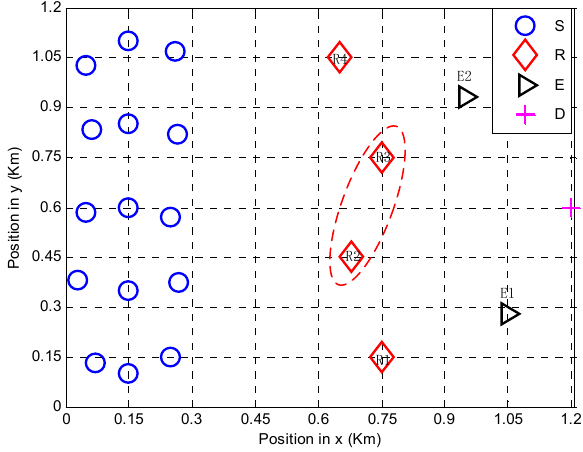
Figure 2. A coalitional structure with eavesdroppers.